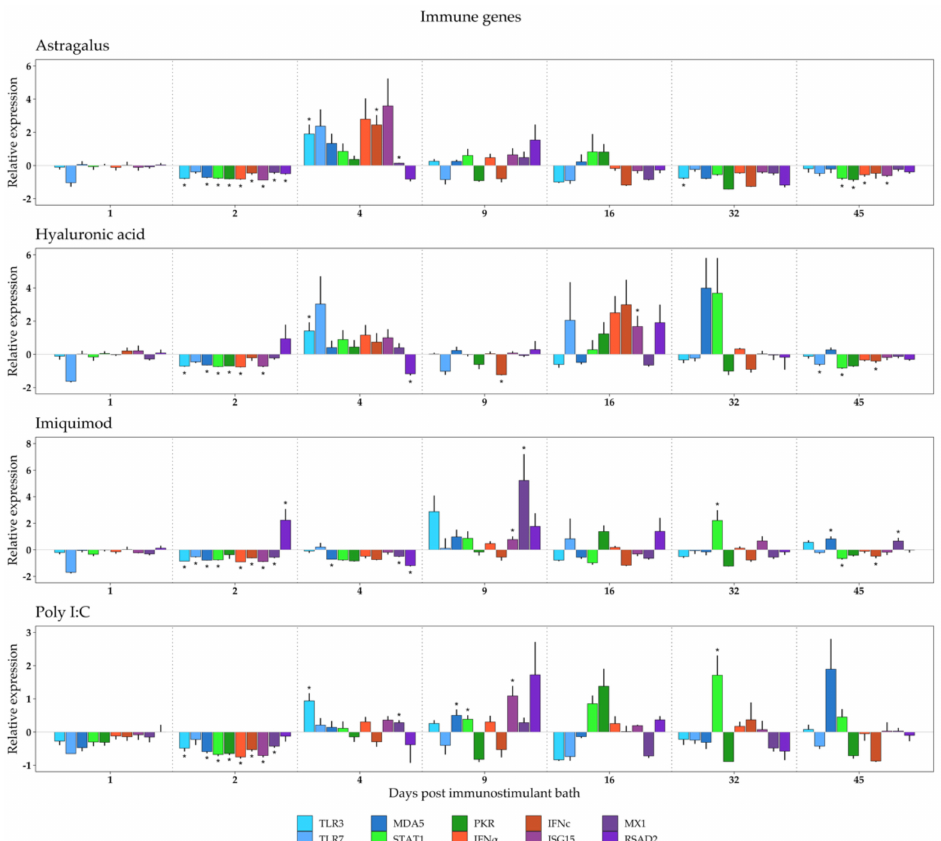
Figure 1. Relative expression of immune genes in Atlantic salmon larvae exposed to Astragalus, Hyaluronic acid, Imiquimod, or Poly I:C, sampled at 1, 2, 4, 9, 16, 32, and 45 days post immunostimulant bath. Transcription levels were assessed through qPCR and are presented as the mean ± standard error of mean gene expression relative to the expression of an HKG (18S). Different gene families are color coded in the following manner: blue—PRR; green—transcription factors; orange— interferons; purple—interferon-stimulated genes. Asterisks indicate p < 0.05 in a t -test. N =